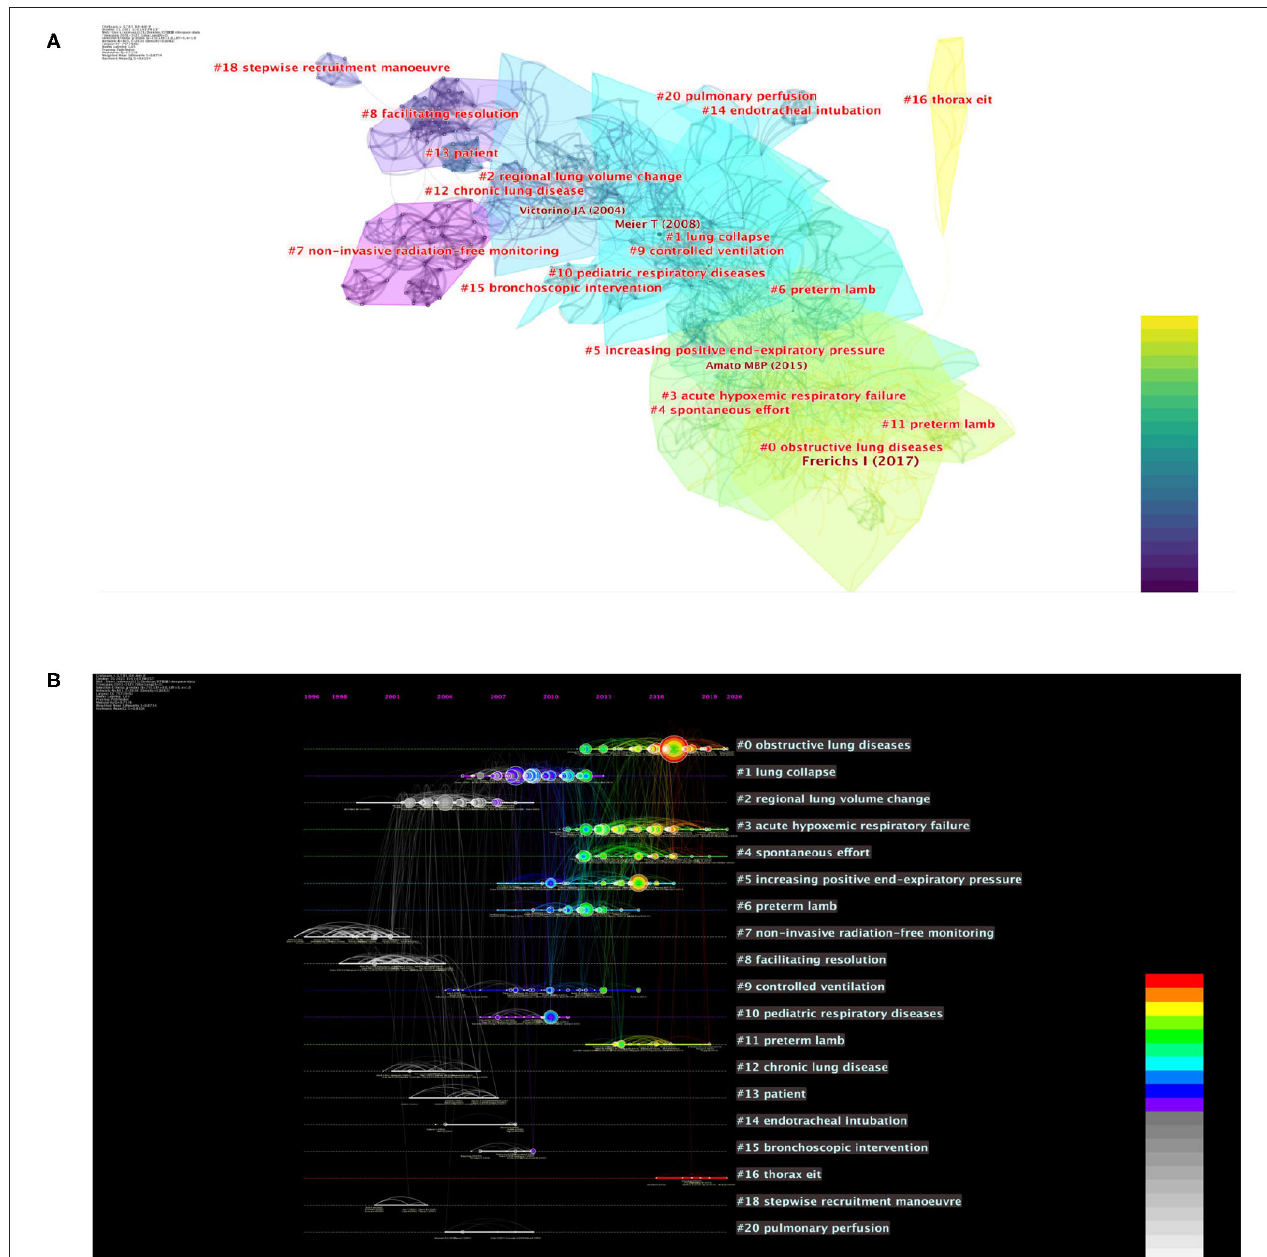
FIGURE 5 | The co-cited reference clustering and time evolution analysis on EIT applications in clinical lung monitoring research from 2001 to May 29, 2021. (A) Co-cited reference network clustering analysis. The color indicates the publication year. The descending order vertically indicated cluster size. The line thickness indicated the strength of linkage. (B) The co-cited reference time evolution analysis. The color indicates the publication year. The colored curves represent co-citation links added in the year of the corresponding color. The large-sized nodes indicated they are either highly cited or have citation bursts or both. The descending order vertically indicated cluster size. The publication year is indicated above the